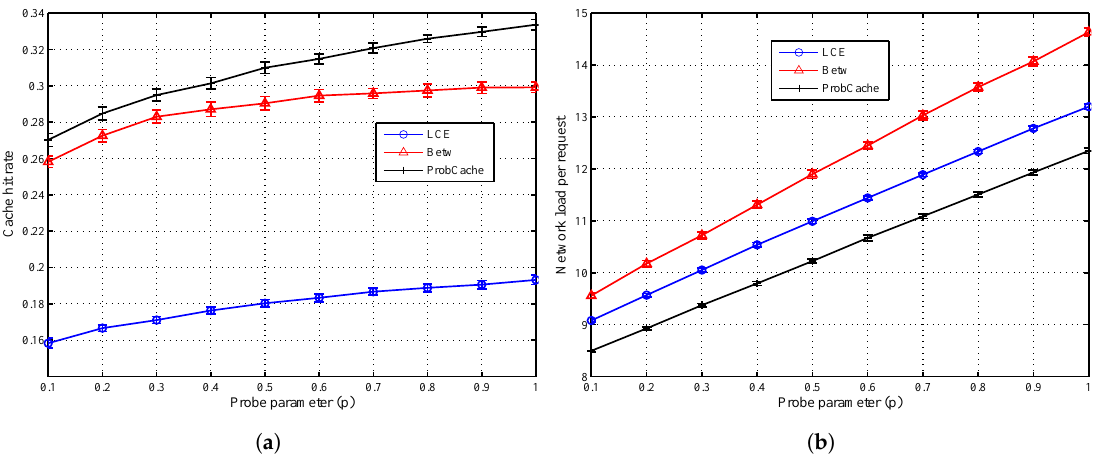
Figure 3. Evaluation of the probe parameter (p) under different on-path caching policies. ( a ) Cache hit rate; ( b ) Network load per request. Each CR is equipped with a cach size of 1% of the content catalogue. Content popularity is modelled according to the Mandelbrot-Zipf (MZipf) distribution with the settings: α = 1.0 and p = 5.0. The results reported are the average of 20 randomized simulation